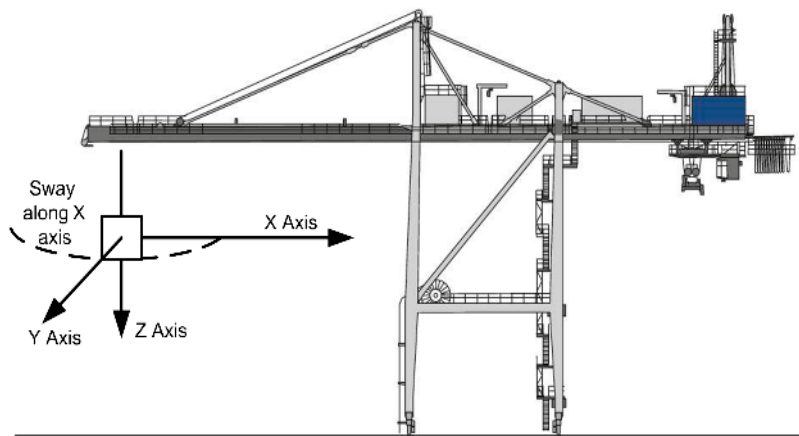
Figure 8. The coordinate system is used to describe the movement of the